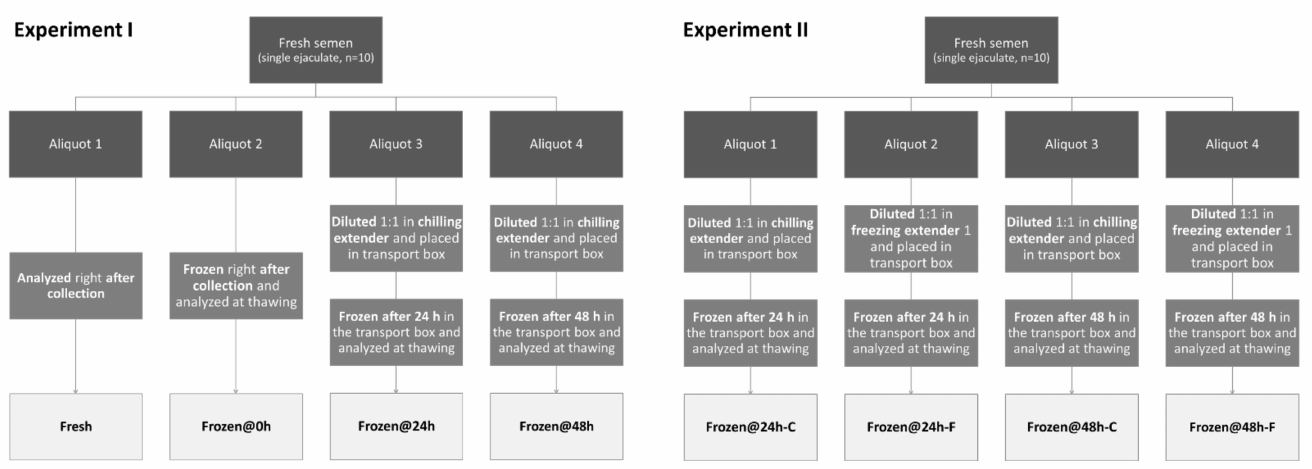
Figure 1. Experimental